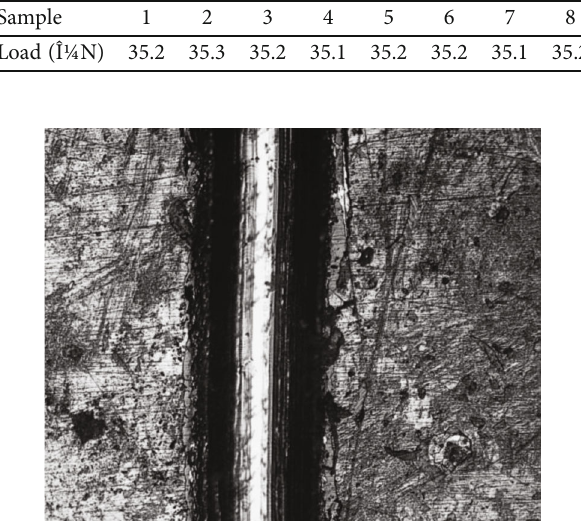
Figure 6: Wear track on DLC coating deposited on Al